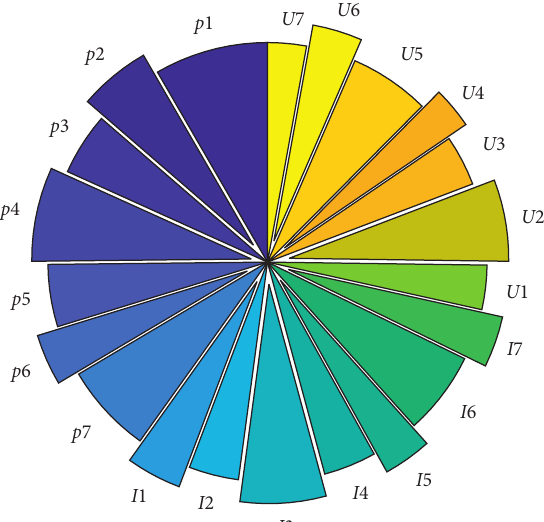
Figure 6: Comparison of recommendation result coverage rate ( P � Personalized recommendation, I � Item-Based CF, U � User-Based CF).